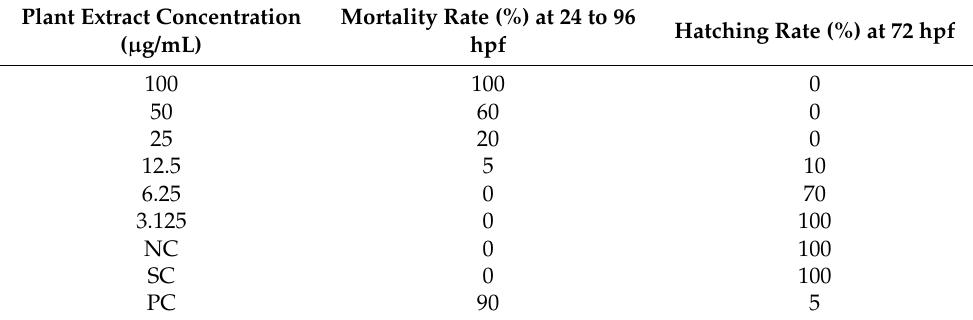
Table 4. Mortality rate (24 to 96 hpf) and hatching rate (72 hpf) of the developing zebrafish embryos treated with different concentrations of 100% v/v methanol extract of P. malayana leaves. Plant Extract Concentration ( µ g/mL) hpf